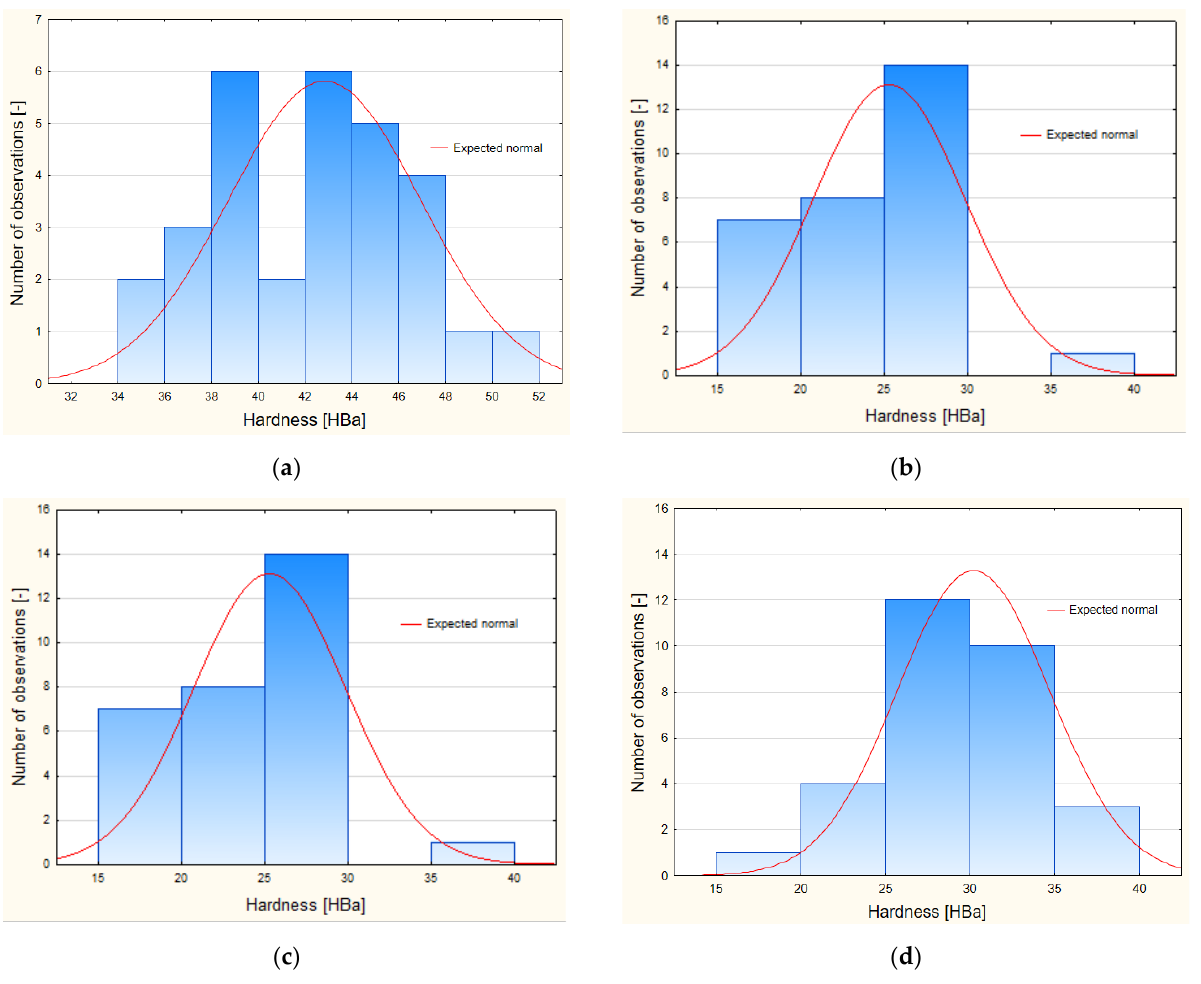
Figure 3. Histogram hardness HBa for: ( a ) sample B0, Shapiro – Wilk W = 0.97431, p = 0.66237, x ≤ class boundary; ( b ) sample A2, Shapiro – Wilk W = 0.96963, p = 0.52897, x ≤ class boundary ; ( c ) sample R10, Shapiro – Wilk W = 0.93655, p = 0.07345, x ≤ class boundary ; ( d ) sample R10A2, Shapiro – Wilk W = 0.96540, p = 0.42213, x ≤ class boundary .